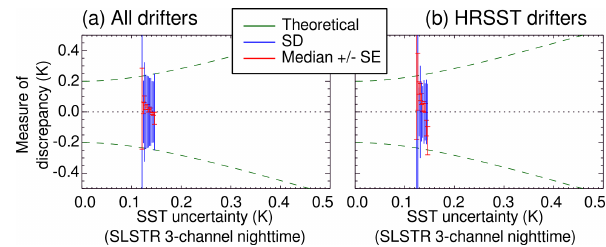
Figure 4. SLSTR SST uncertainty validation plot for (a) all drifters and (b) a subset of HRSST-1 and HRSST-2 drifters, with uncer- tainty bins of 0.01K. An uncertainty of 0.20K is assumed for the drifter